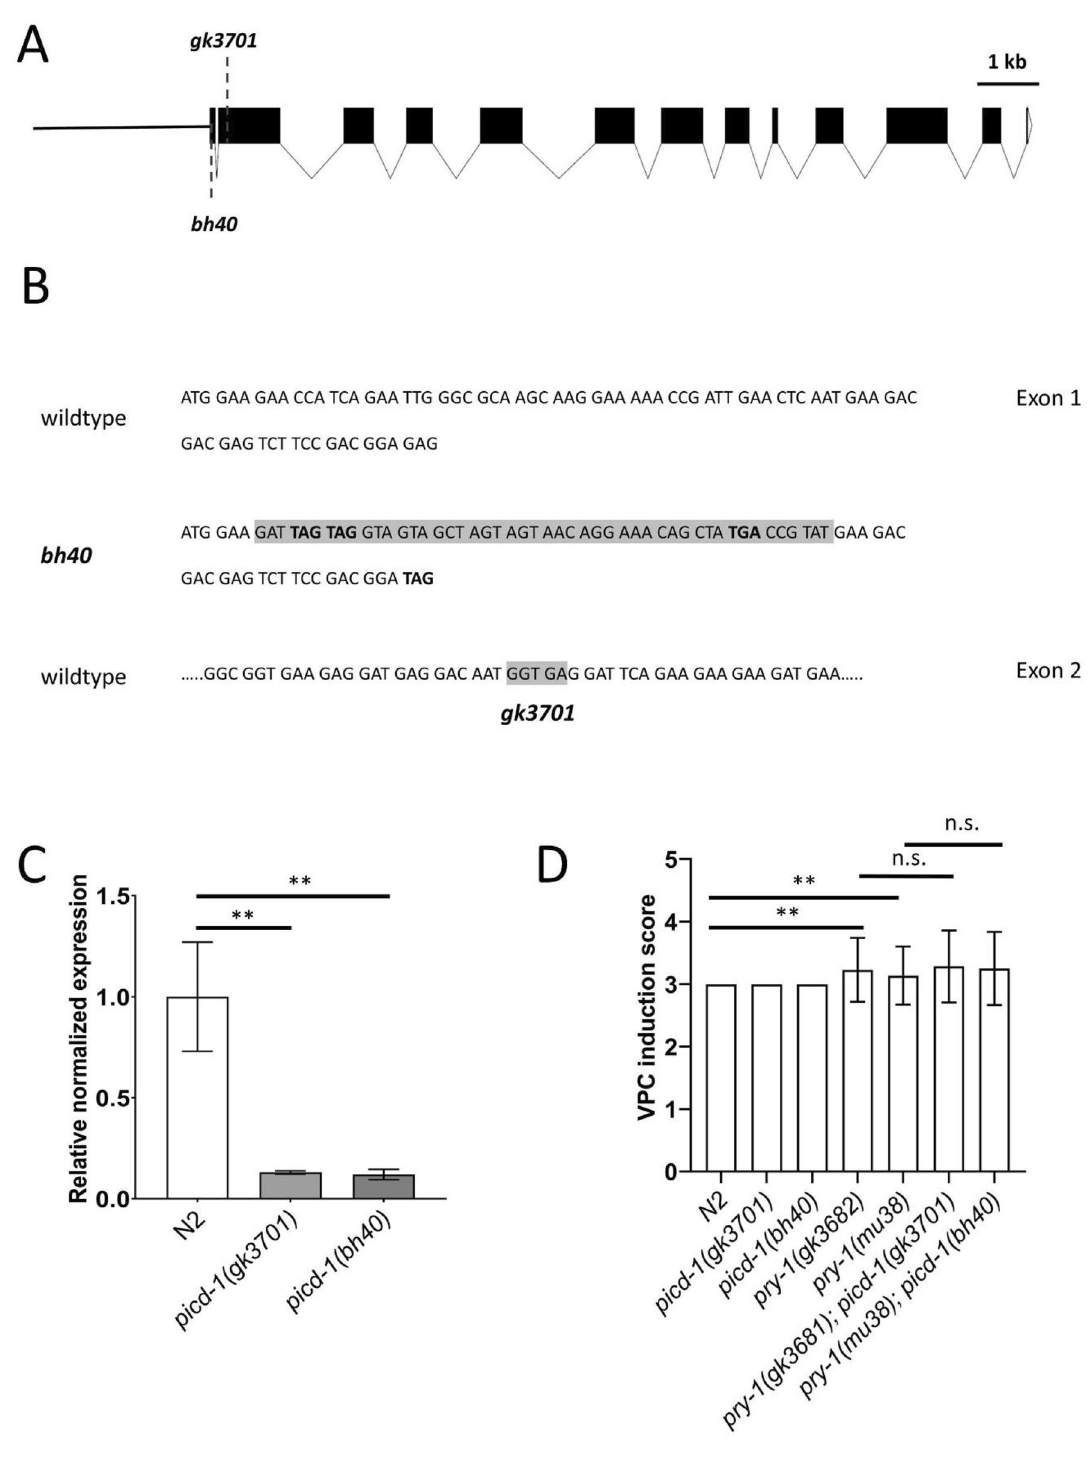
Figure 2. Analysis of picd-1 alleles and their effect on pry-1 mutant Pvl phenotype. ( A ) Schematic diagram of the picd-1 open reading frame. The approximate locations of bh40 and gk3701 mutations have been indicated. ( B ) Sequences for bh40 and gk3701 mutations are shown in gray color. and stop codons are shown in bold (also see “Methods”). ( C ) Expression levels of picd-1 in pry-1(gk3682) and pry-1(mu38) mutants at the L1 stage compared to wild-type. Data represent the means of two replicates and error bars represent the standard error of means. p values were calculated using Bio-Rad software (one-way ANOVA). ( D ) Bar graph showing VPC induction score in picd-1 and pry-1 mutants alone, and pry-1; picd-1 double mutants compared to N2. Data represent the means of two replicates. The error bars show the standard deviation (n = 22). Statistical analyses were done using one-way ANOVA with Dunnett’s post hoc test. In panels ( C,D ), significant differences are indicated by stars (*): ** ( p < 0.01). n.s., not